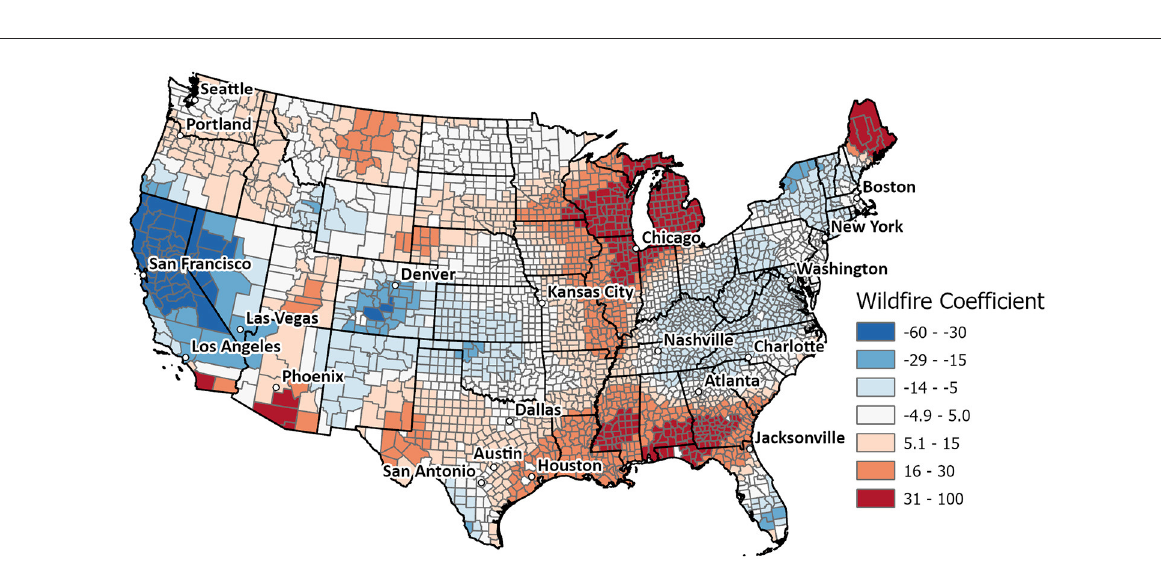
60 to 100. Negative values (in shades of blue) indicate regions where −